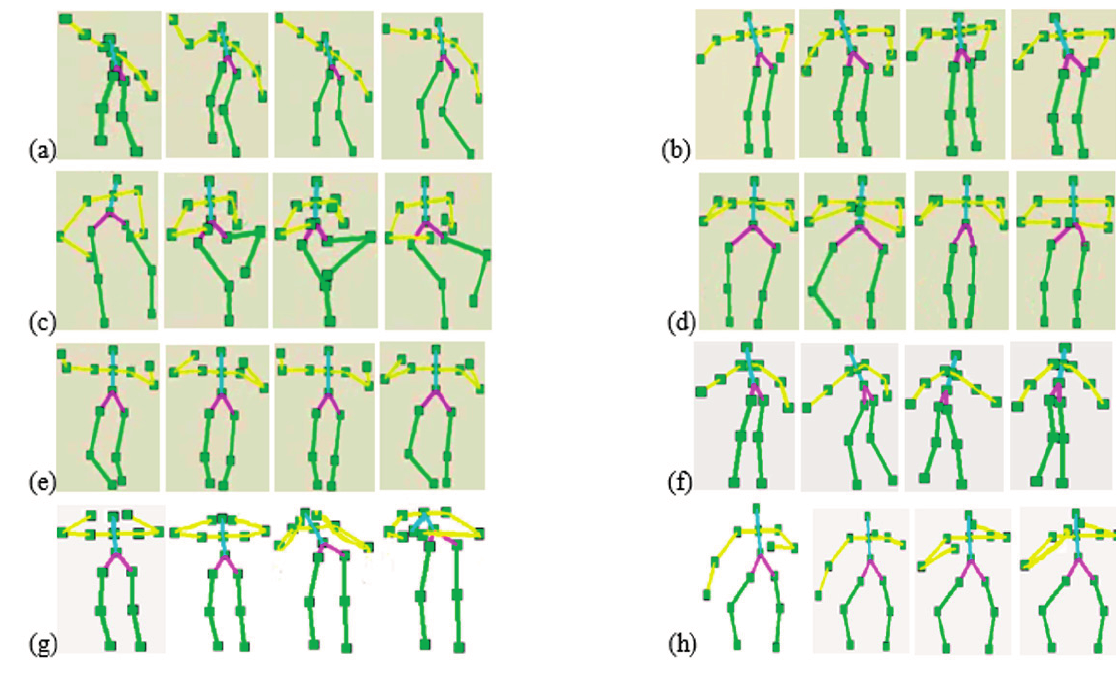
Figure 11. Skeleton representations that illustrate some of our results: ( a ) presentation; ( b ) cooking; ( c ) reading an article; ( d ) hand clapping; ( e ) exercise; ( f ) walking; ( g ) headache and ( h ) taking